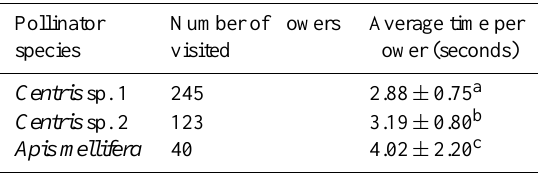
Table 1. Number of O. spectabilis flowers visited by each pollinator species and average time per visit (mean ± SD). Different letters in- dicate statistically significant differences ( p ≤ 0.05) for flower visi- tation